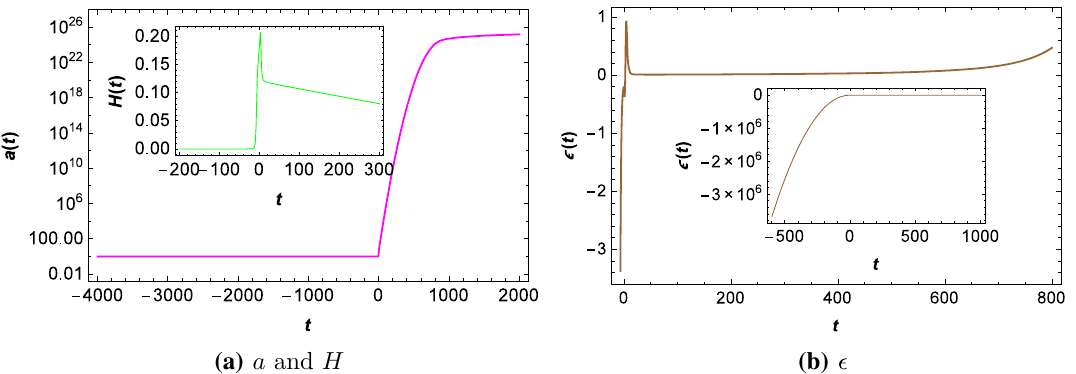
Fig. 2 The evolution of a , H and (cid:6) , while we set f 1 = 5, f 2 = − 0 . 23, f 3 = − 13 f 2 , q 1 = 1, q 2 = 0 . 2, q 3 = 0 . 2, q 4 = 2, λ = 4 × 10 − 4 , φ 0 = 7, φ = 22 . 7 and φ = 5 . 2 1 2